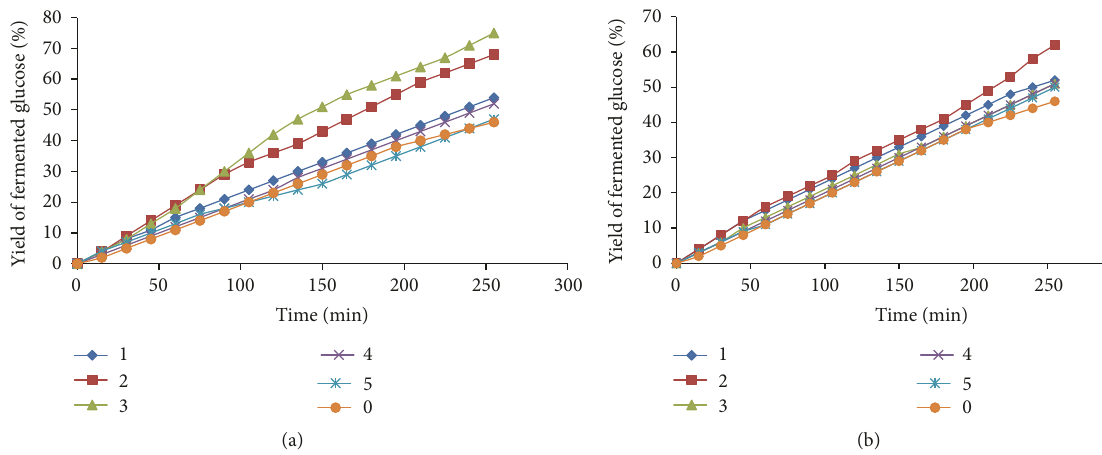
Figure 6: Variation in time of the yield in fermented glucose for the first 5 fermentation cycles (curve 0-free yeast cells), compared with the yield obtained in free yeast fermentation for particles PD2 (a) and PD5 (b).